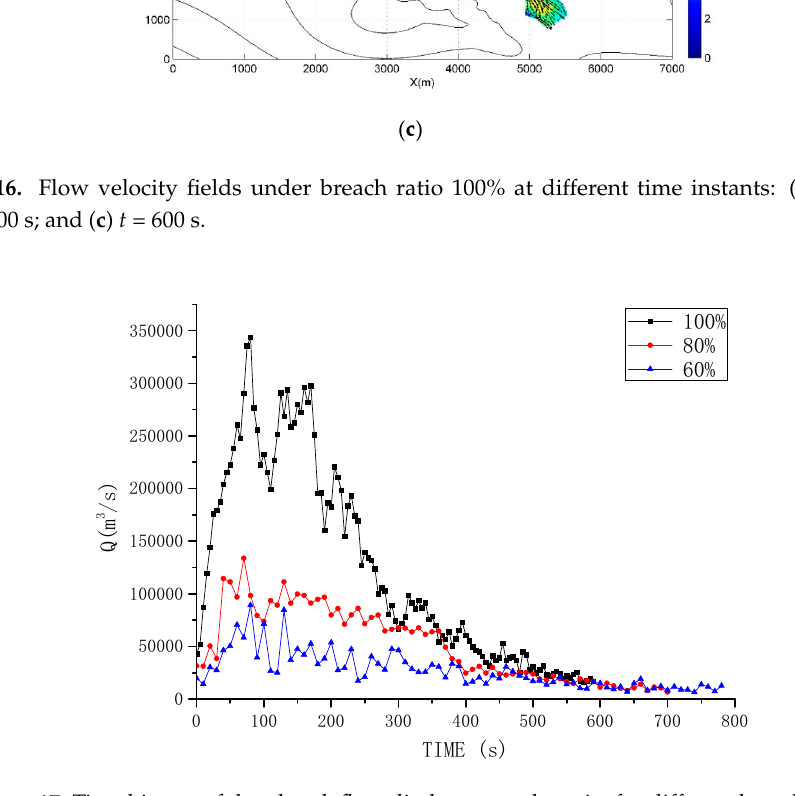
Figure 17. Time history of dam break flow discharges at dam site for different breach ratios.